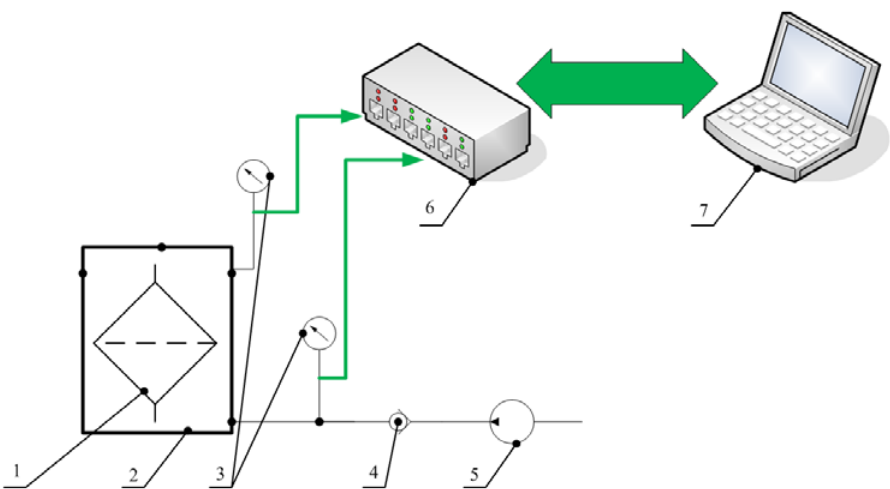
Figure 7. Diagram of a test bench for static loading of an aircraft fuel filter assembly: 1—filter, 2—NC filter body, 3—pressure sensors, 4—one-way valve, 5—manual hydraulic pump, 6—analogue signal translator, 7—computer.